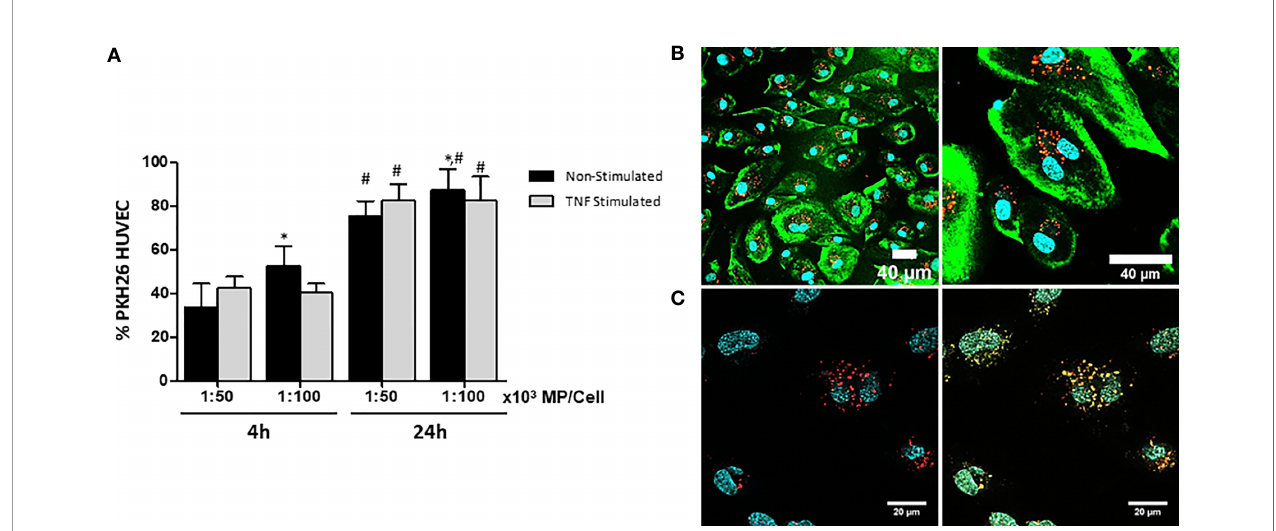
FIGURE 3 | Characterization and quanti fi cation of uptake of MP by unstimulated and TNF a -stimulated HUVEC. MSC were labeled with PKH-26 before generation of MP (PKH-MP). PKH-MP were added to HUVEC (ratio 1:50,000) and incubated for 4 and 24h at 37°C. (A) Uptake of PKH-MP by unstimulated and TNF a -stimulated HUVEC (ratio 1:50,000 and 1:100,000) was quanti fi ed using fl ow cytometry. Uptake is indicated by PKH-MP positive HUVEC (PKH+ HUVEC). (B) Representative confocal microscopy analysis of PKH-MP uptake by HUVEC at time point 24h. Staining for PKH26-MP (red), PKH-67 cell membrane (green), and Hoechst 33342 nucleus (blue) showed that PKH-MP are internalized by HUVEC. Scale bars: 40 m m (C) Staining for PKH-MP (red), lysosomes (yellow) and nucleus (blue) showed that PKH-MP (ratio 1:50,000) are co-localized with lysosomes in HUVEC after 24h of incubation. Scale bars: 20 m m.